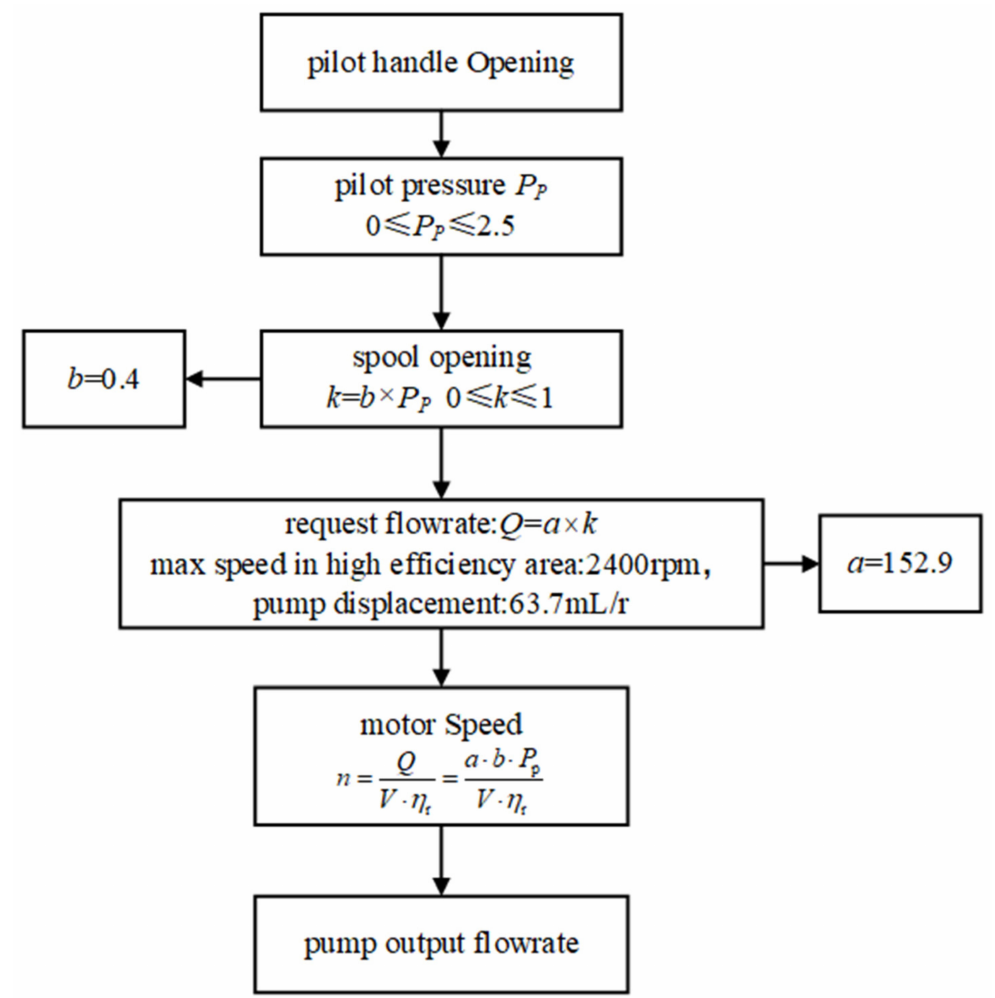
Figure 9. Control flow chart of the positive flow